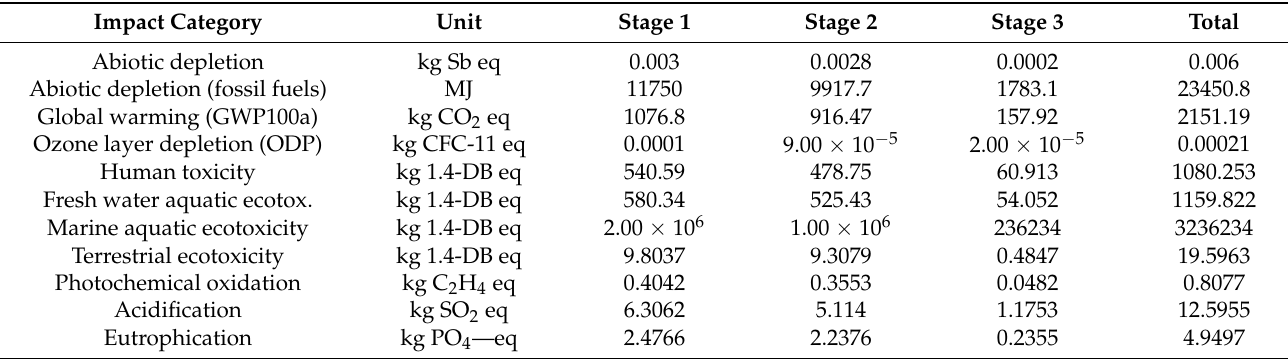
Table 20. Impacts generated by each stage of the activity of manufacturing 2-piece stopper with dimensions of 24 × 44 by